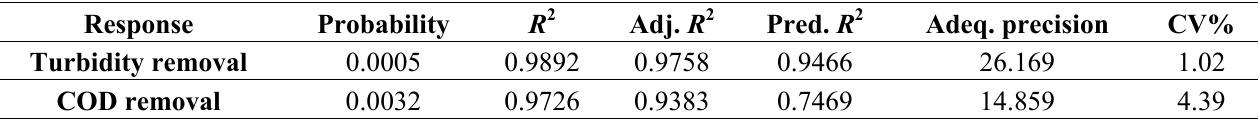
Table 4. ANOVA results for response models.